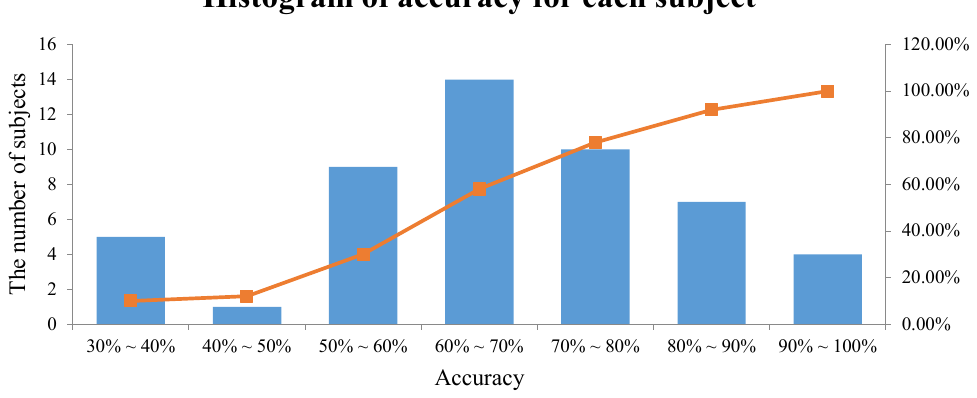
Figure 10. Histogram of the accuracy for each subject in the proposed method.